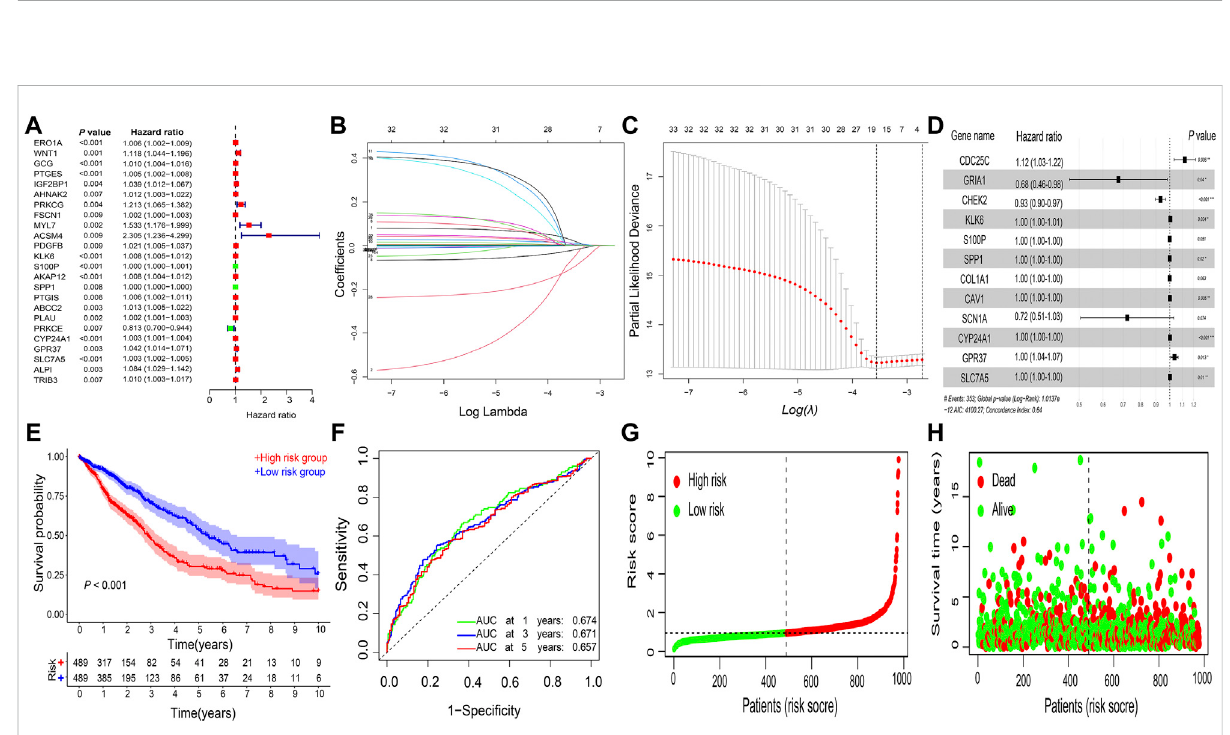
FIGURE 2 Constructionofgenesignature.Genesignatureconstructedusing (A) univariateCoxregressionanalysisand (B – D) LASSOregressionanalysisin NSCLC. (E) Kaplan – Meier survival analysis. (F) ROC curve analysis. (G) risk score distribution. (H) survival status of the prognostic gene signature. LASSO,leastabsoluteshrinkageandselectionoperator;NSCLC,non-smallcelllungcancer;ROC,receiveroperatingcharacteristic;AUC,areaunder the ROC